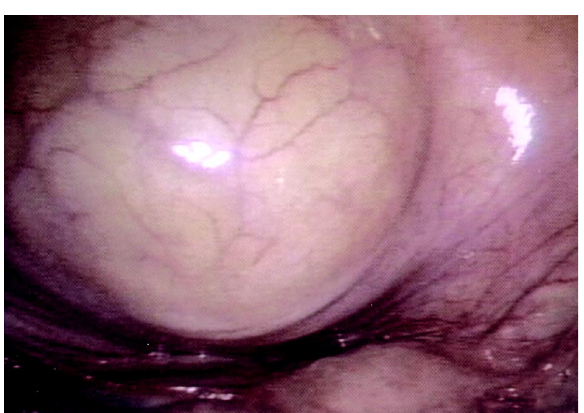
Figure 1 – Initial laparoscopic viewing of the bladder following umbilical puncture (0-grade optics).